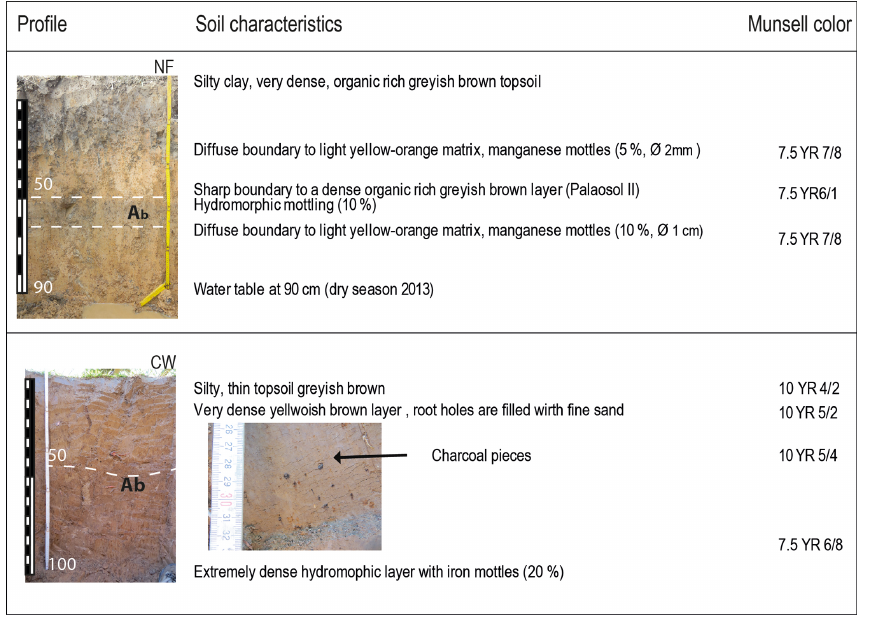
Figure 2. Profile description: Munsell colour signature is given for each layer, water table boundaries are illustrated as blue dashed lines, Ab = buried topsoil. Table 2. AMS radiocarbon ages of charcoal and soil samples, given both as 14 C age BP and calibrated radiocarbon age in AD/BC format at two-sigma level. OSL ages are given as years before sampling (rounded to the next 5 years) and converted to AD/BC format to allow direct comparison with radiocarbon